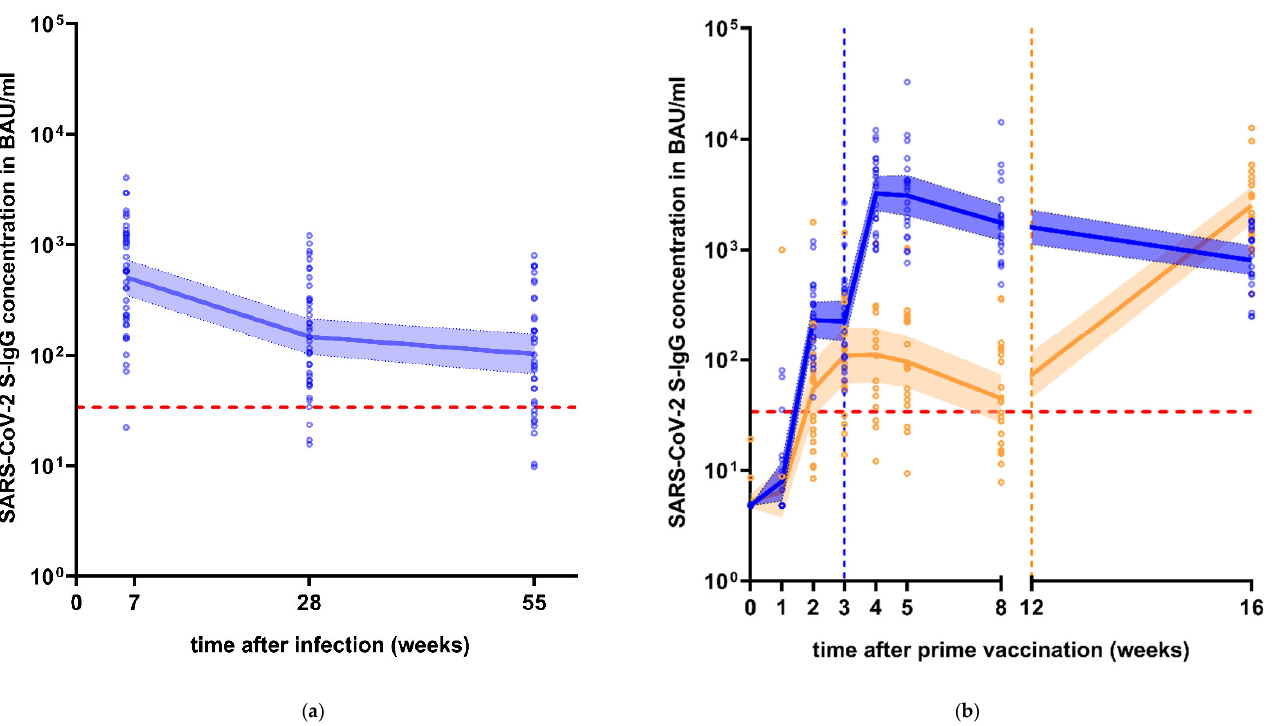
Figure 1. Longitudinal course of SARS-CoV-2 S-IgG antibody levels after infection and vaccination. Red dotted line = manufacturer’s positive cut-off at 33.8 BAU/mL. ( a ) S-IgG levels in 40 subjects post-infection over one year, excluding subjects at 55 weeks that received a vaccination in-between follow-ups. ( b ) S-IgG levels after homologous (blue) and heterologous (orange) vaccination. Dotted vertical lines = time of booster vaccination for homologous (blue) and heterologous (orange) vaccination regimen.